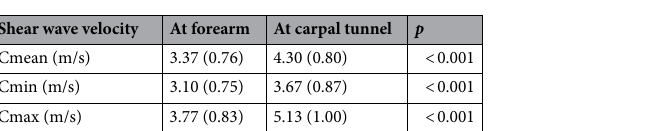
Table 3. Comparison of median nerve shear wave velocity in different parts.